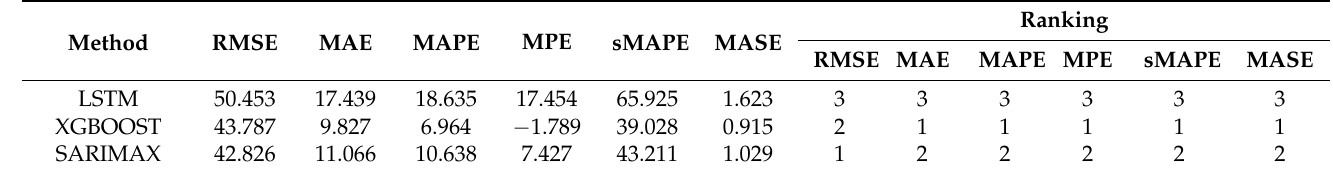
Table 6. Results & ranking of the performance metrics.